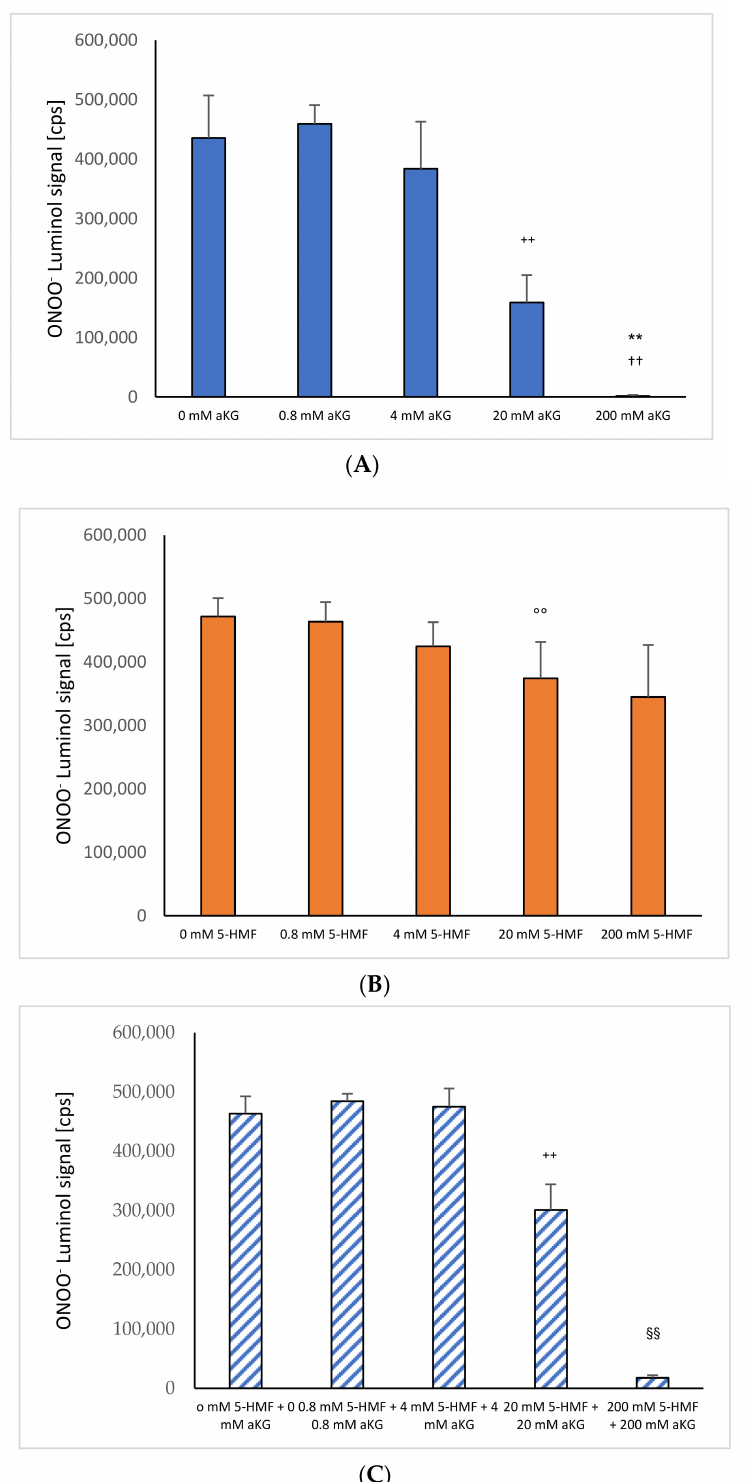
Figure 1. ONOO − induced luminol measurements after 1 s in the absence or presence of ( A ) 0–200 mM aKG ( n = 5); ( B ) 0–200 mM 5-HMF ( n = 5); ( C ) aKG (0–200 mM) + 5-HMF (0–200 mM; n = 5). ** p < 0.01: significance between 20 and 200 mM aKG compared to 4 mM aKG; †† p < 0.01: significance between 20 and 200 mM aKG; ◦◦ p < 0.01: significance between 0 mM 5-HMF and 20 and 200 mM 5-HMF; ++ p < 0.01: significance between 4 mM of combined aKG + 5-HMF and 20 mM of combined aKG + 5-HMF. §§ p < 0.01: significance between 200 mM combined aKG + 5-HMF and 20 mM combined aKG +